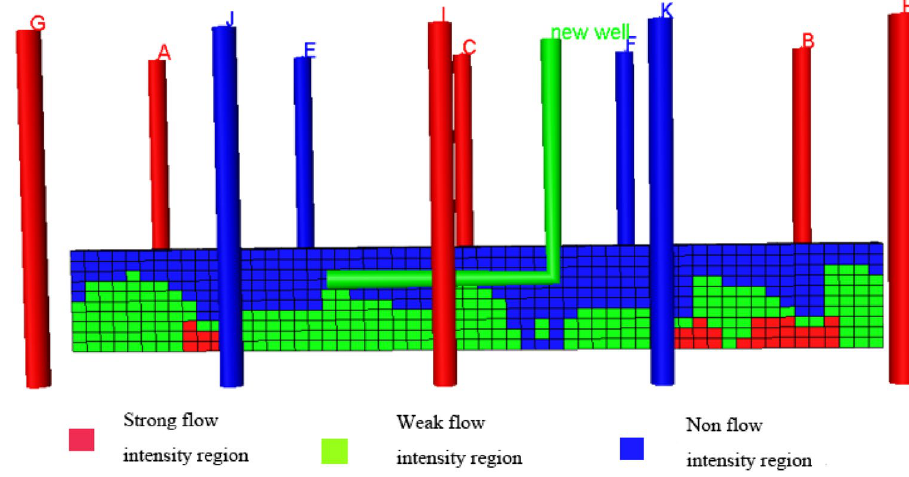
Fig. 11 Optimal location map of horizontal well excavation in weak flow field